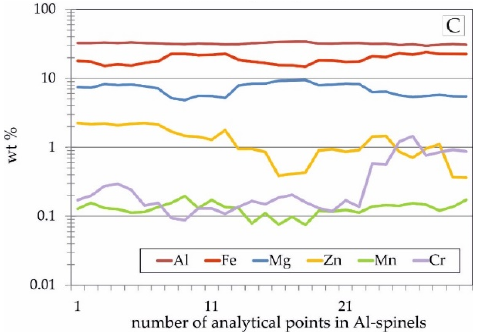
Figure 9. Variation in the content of elements in the chemical composition of magnetite ( A ), ilmenite ( B ), and Al-spinels ( C ) from the Krzemianka and Udryn Fe-Ti-V deposits in NE Poland.